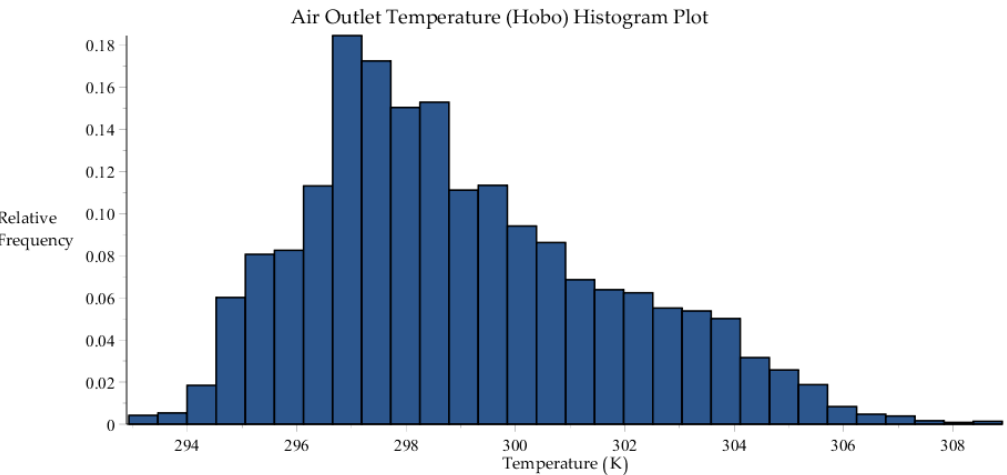
Figure A4. Histogram plot of the air outlet temperature measured using “Hobo” sensors, within the 6717 data sets collected by SRNL from F-Area cooling towers.